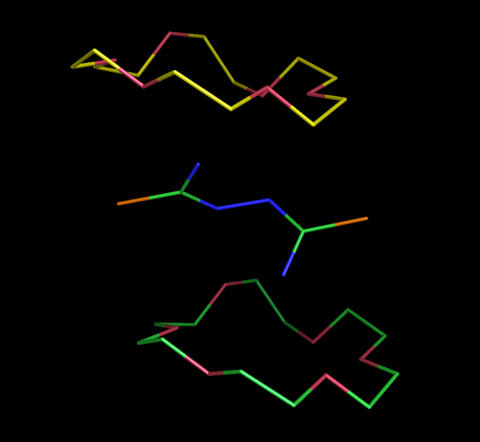
The dithiobiurea–18-crown-6 complex with the strongest intermolecular interaction energy that was identified by the EUDOC program using local minimum conformations of dithiobiurea.The nitrogen and sulfur atoms are blue and orange, respectively. The carbon atoms of the primary and neighboring hosts are green and yellow, respectively.